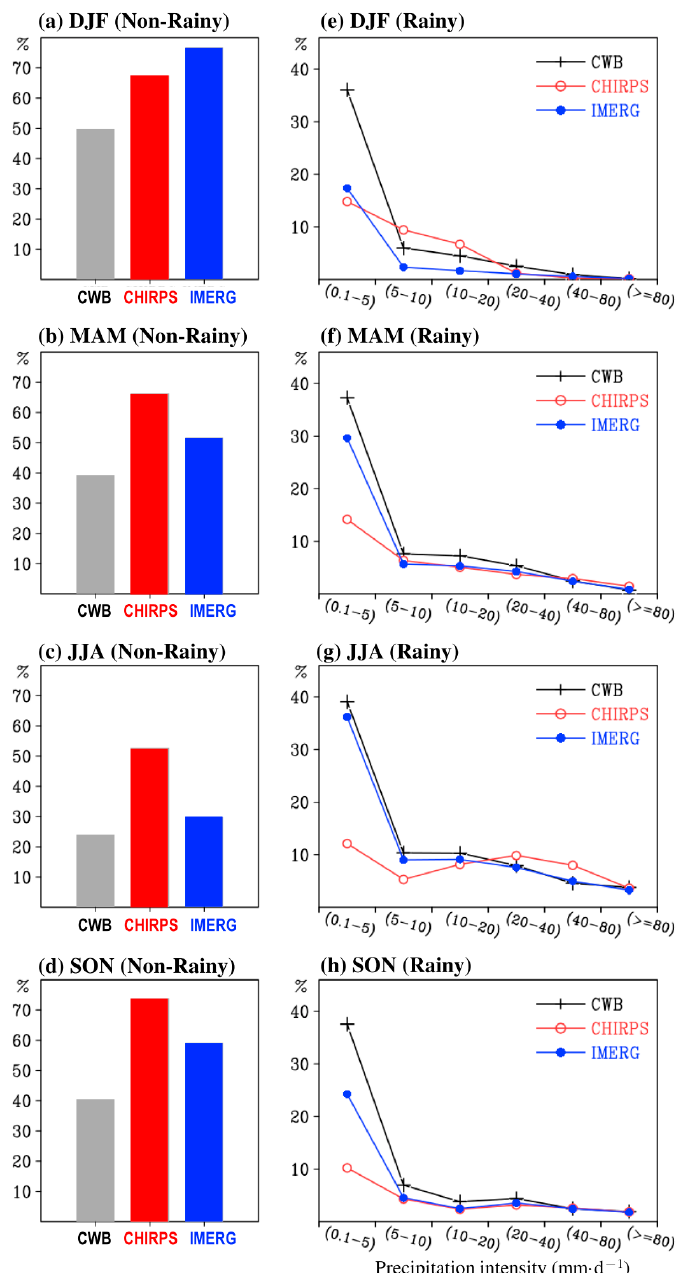
Figure 10. ( a – d ) show percentages of non-rainy grids (defined as daily precipitation ≤ 0.1 mm/day) in all grids of CWB, CHIRPS, and IMERG for winter (DJF), spring (MAM), summer (JJA), and autumn (SON). ( e – h ) show the percentages of different criteria of rainy grids (defined as daily precipitation >0.1 mm/day) in all grids of CWB (black line), CHIRPS (red line), and IMERG (blue line) for the four seasons.